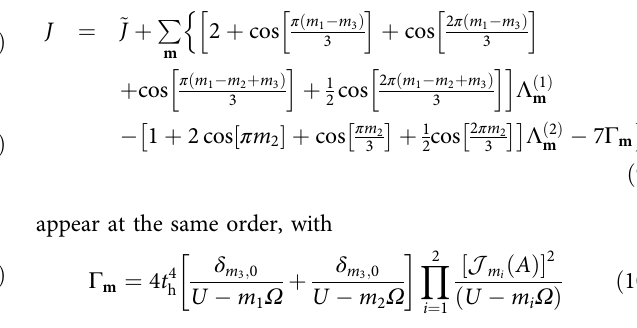
where m = { m 1 , m 2 , m 3 } are Floquet indices, and